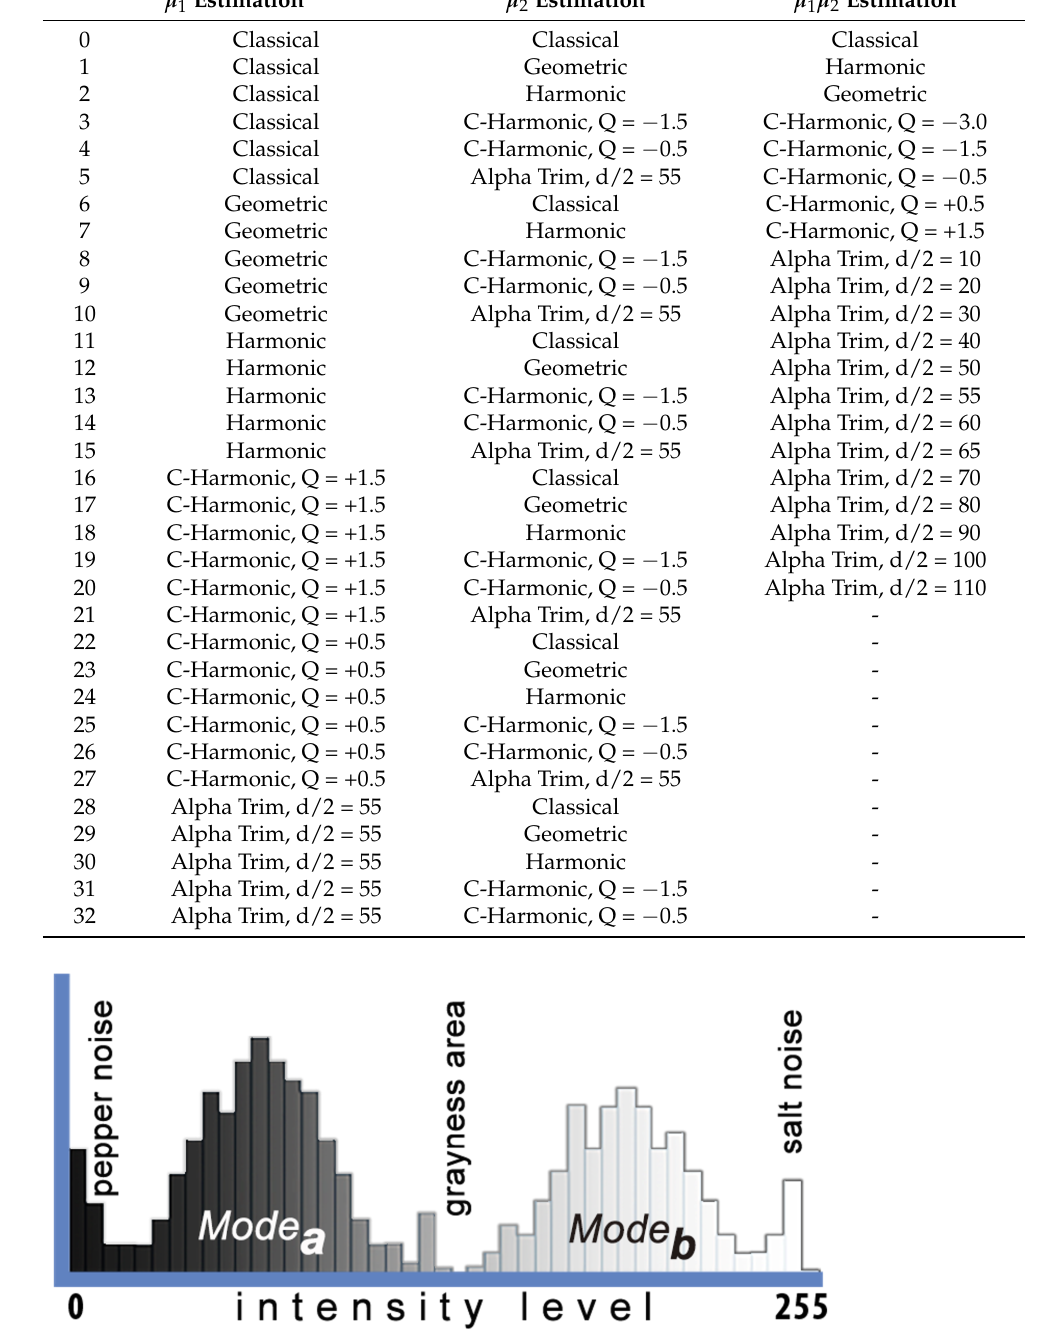
Figure 1. Visualization of the impact of intensity levels in an image histogram.